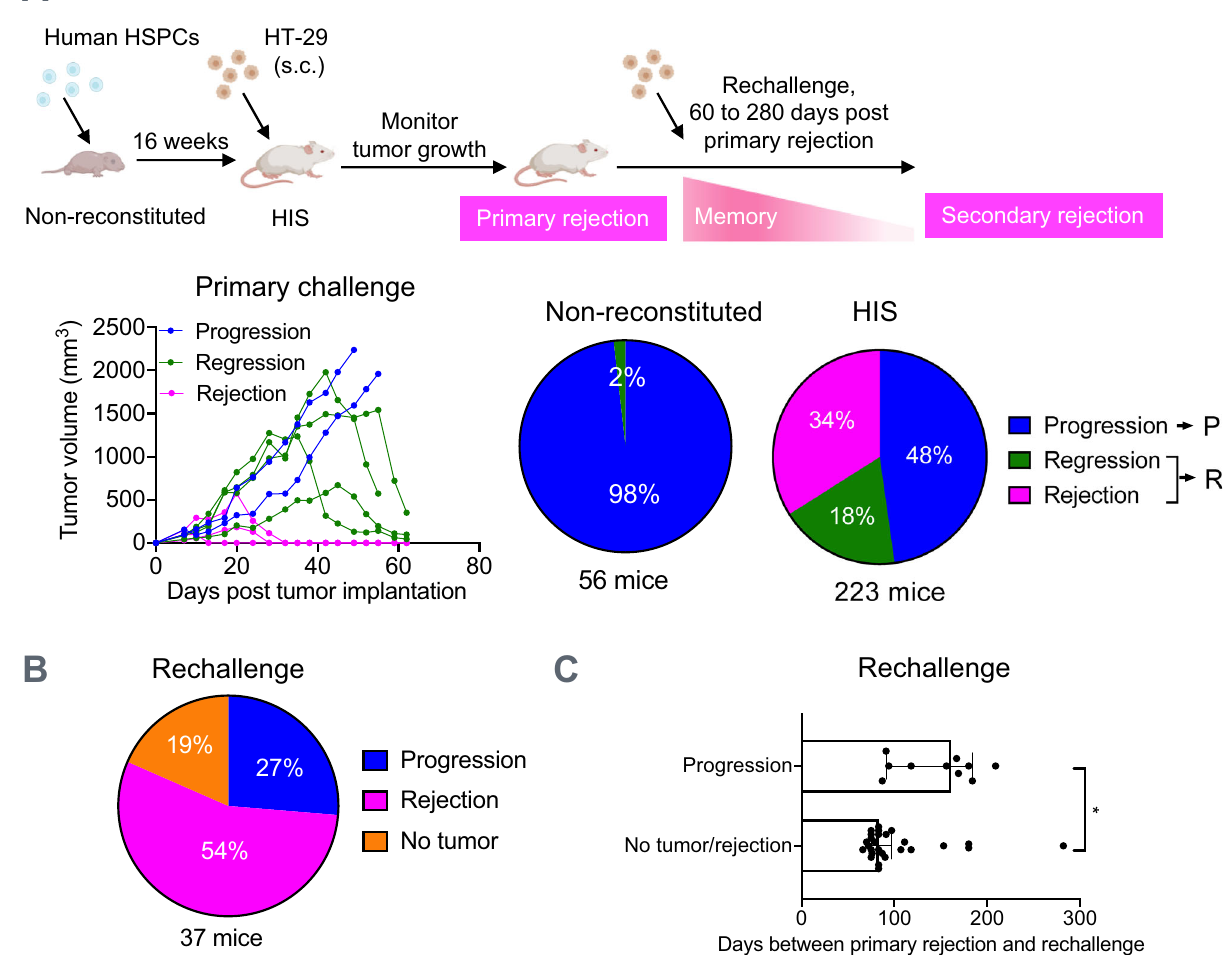
Fig. 1 HIS mice show potent tumor growth control and memory responses against HT-29. A Schematic of HIS tumor studies (created with BioRender.com), tumor growth curve of a representative cohort, and summarized tumor growth outcome of 56 non-reconstituted and 223 HIS mice following the primary HT-29 tumor challenge. Tumor growth curve is generated using repeated measurements of the same mouse overtime. Summarized tumor growth outcome results are shown as pie charts. The numbers in the pie charts represent the fraction of mice for each tumor growth outcome. The 223 HIS mice were reconstituted with HSPCs from 27 human donors. Regression is de fi ned as having two tumor volume values smaller than the preceding peak value. Progression group: P; combined regression and rejection groups: R. B Mice that rejected HT-29 tumors during the primary challenge were rechallenged with HT-29 cells. The 37 mice were reconstituted with HSPCs from 10 human donors. C Comparison of the time span between primary tumor rejection and rechallenge tumor growth outcome. Results of tumor progression ( n = 10) and no tumor/rejection ( n = 27) are shown as median ± 95% con fi dence interval. * p < 0.05, unpaired t